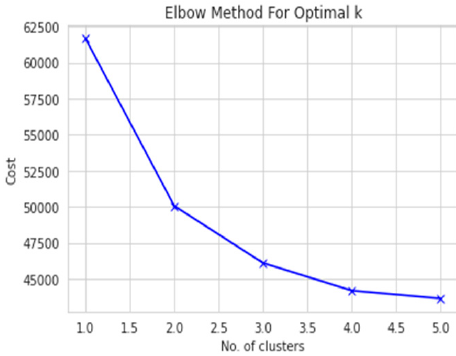
Figure 4. Female dataset.